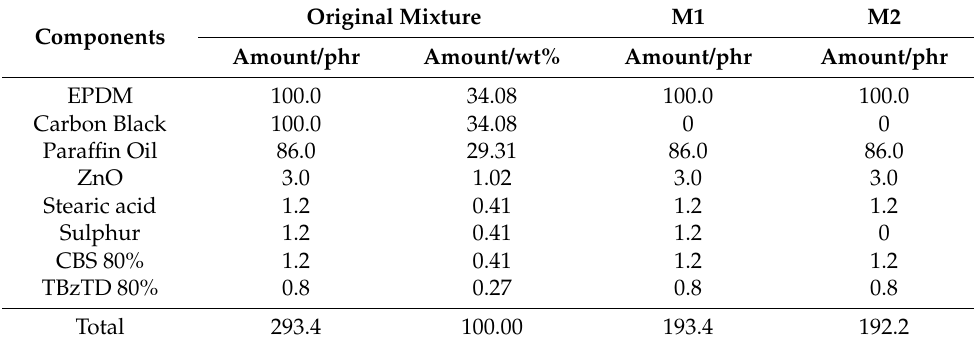
Table 1. Compositions of the original EPDM mixture and the two mixtures M1 and M2 derived from it.